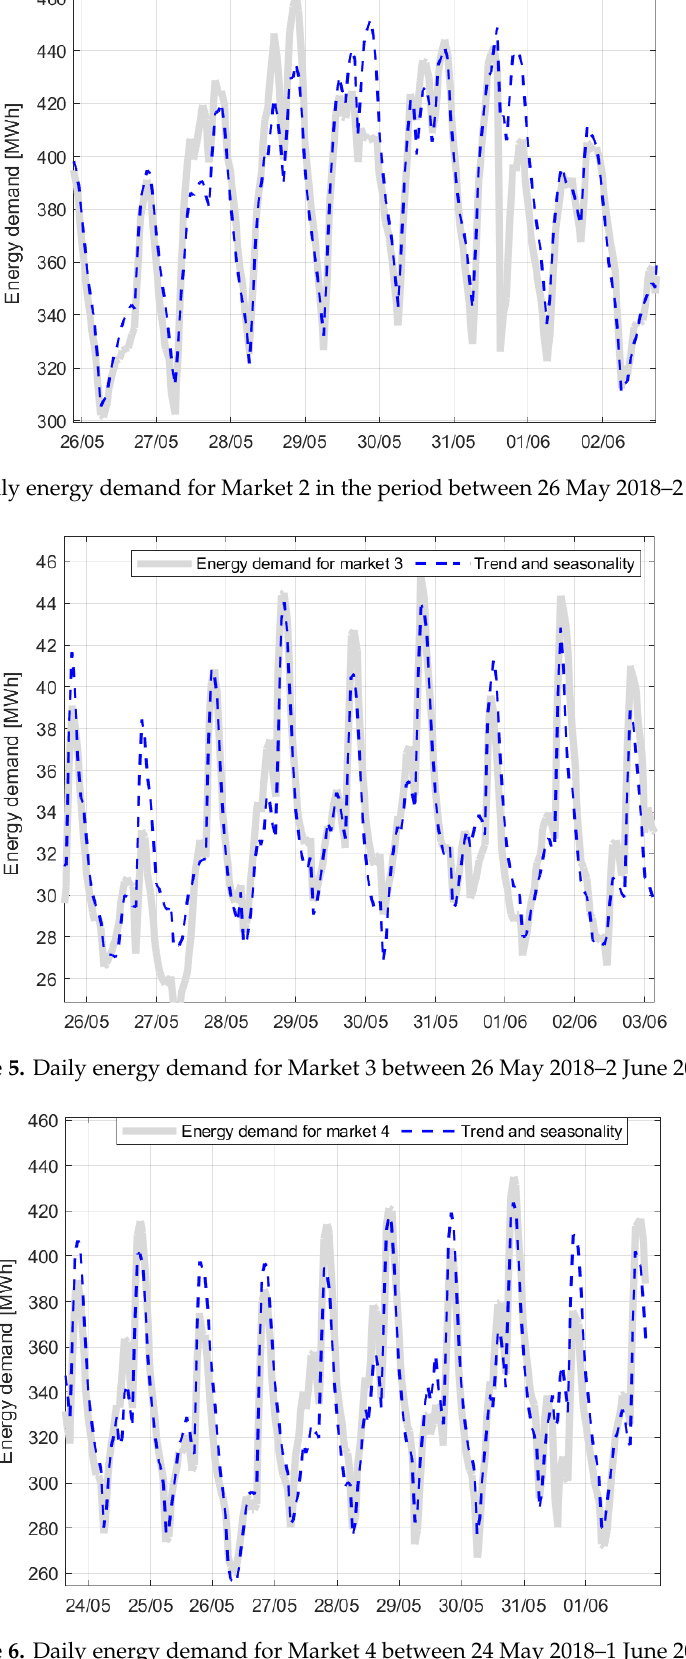
Figure 7. Daily energy demand for Market 5 between 2 – 14 May 2018. Table 1 shows the statistical characteristics of the energy demand profile. Weekdays presented similar mean and median in the energy demand, on the contrary to Saturdays and Sundays/holidays. Table 1 reveals that there was data concentration to the left of the mean due to the reported positive asymmetry. Similarly, kurtosis values were similar for all types of days and lower than three, showing a shape not as sharp and with wider tails compared to a normal distribution.